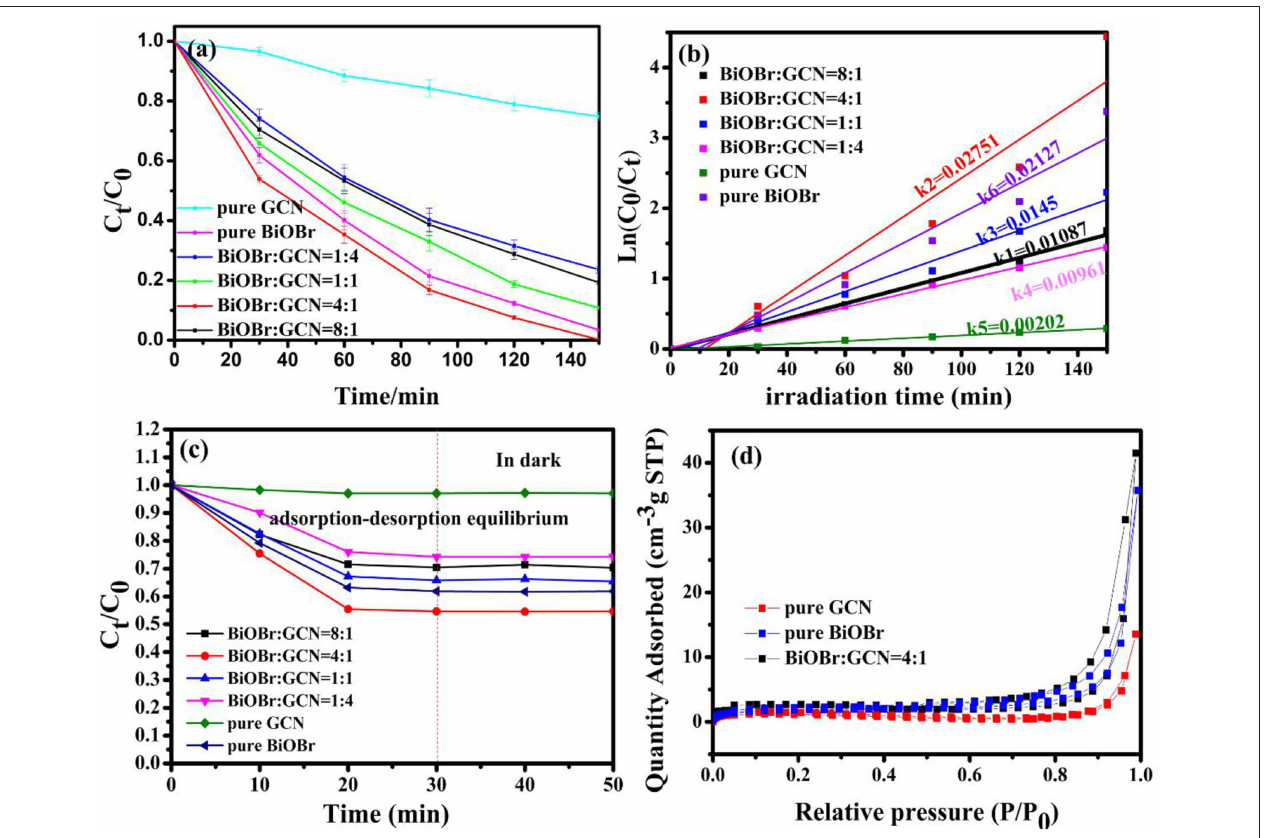
FIGURE 7 | (a) Photocatalytic activity; (b) plot of In(C 0 /C t ) vs. irradiation time over pure BiOBr and pure g-C 3 N 4 , BiOBr-g-C 3 N 4 composites; (c) adsorption curves of BPA in the dark; (d) N 2 adsorption-desorption isotherms curves.